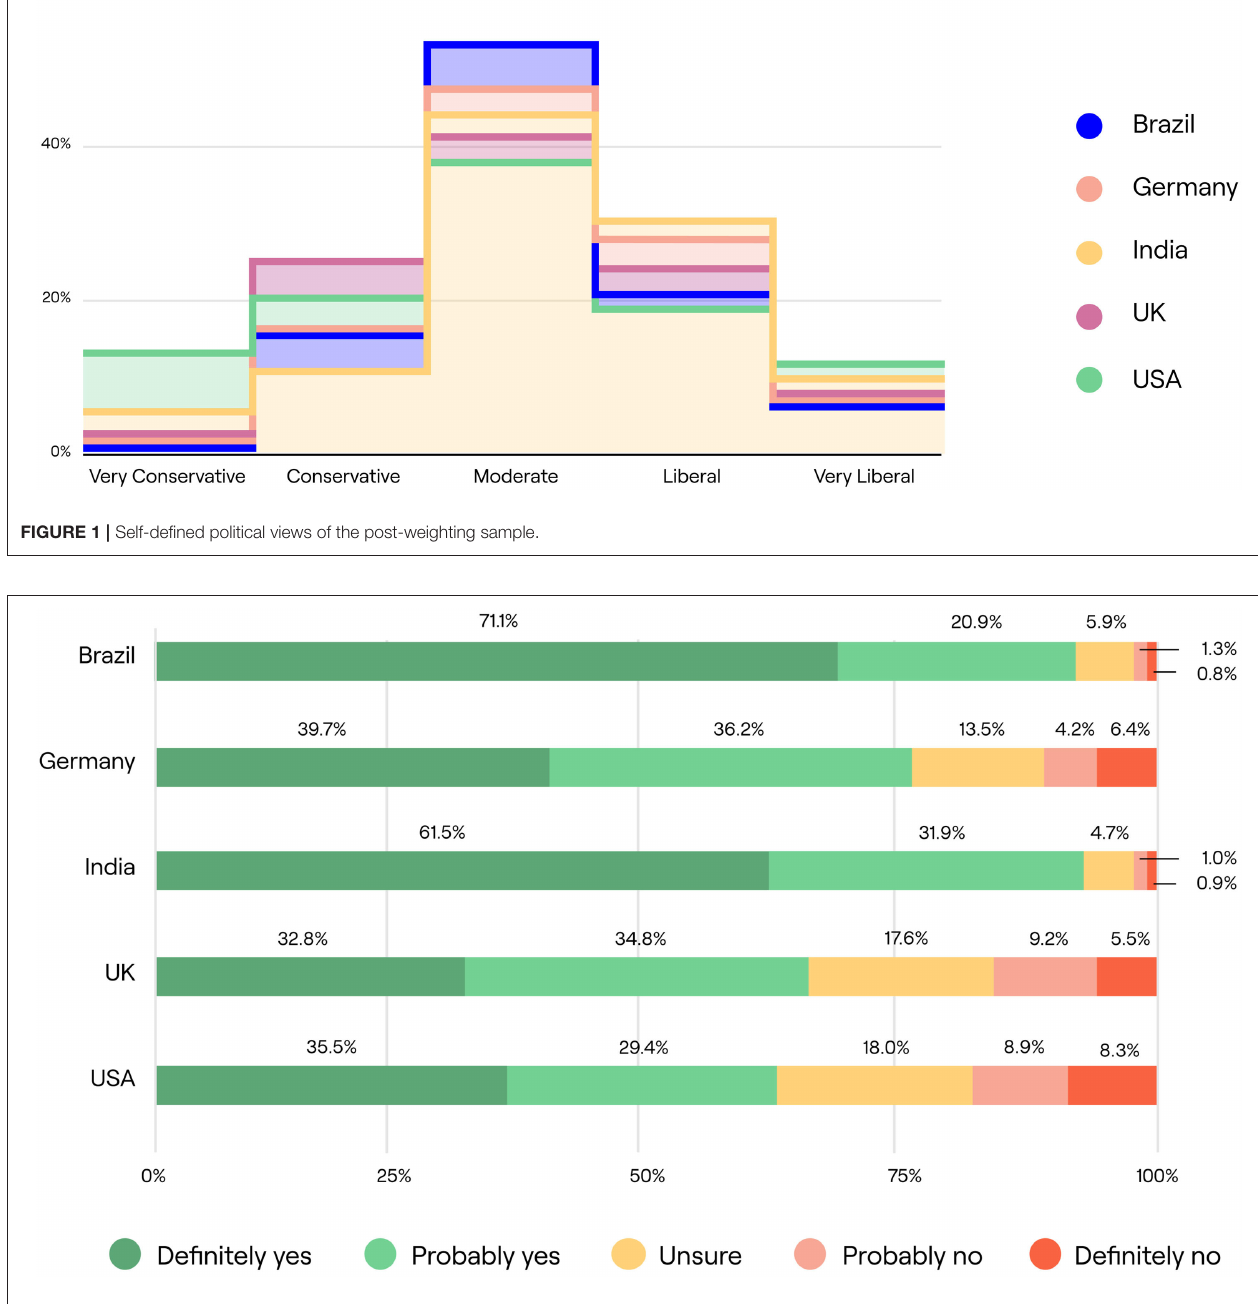
FIGURE 2 | Willingness to try animal-free dairy cheese across countries.